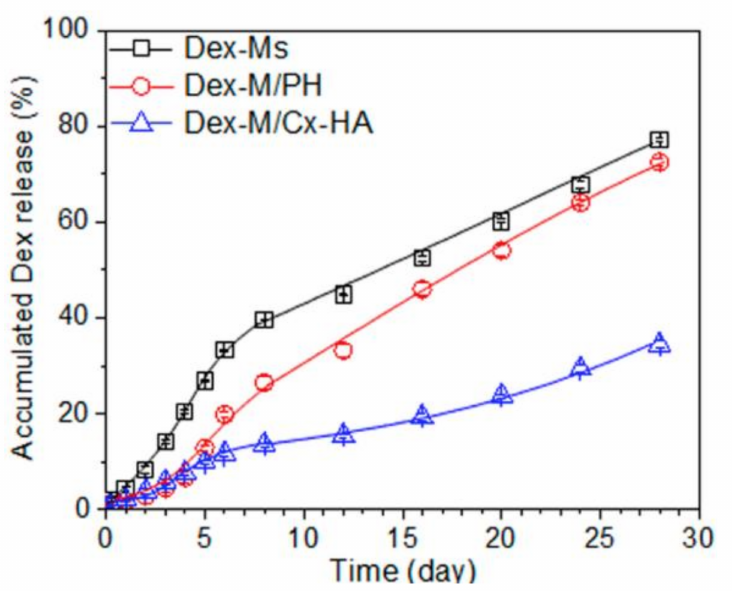
Figure 5. Accumulated in vitro release of DEX of microparticles and hydrogel alone and the compos- ite system. (Adapted with permission from [38]. Copyright (2019)